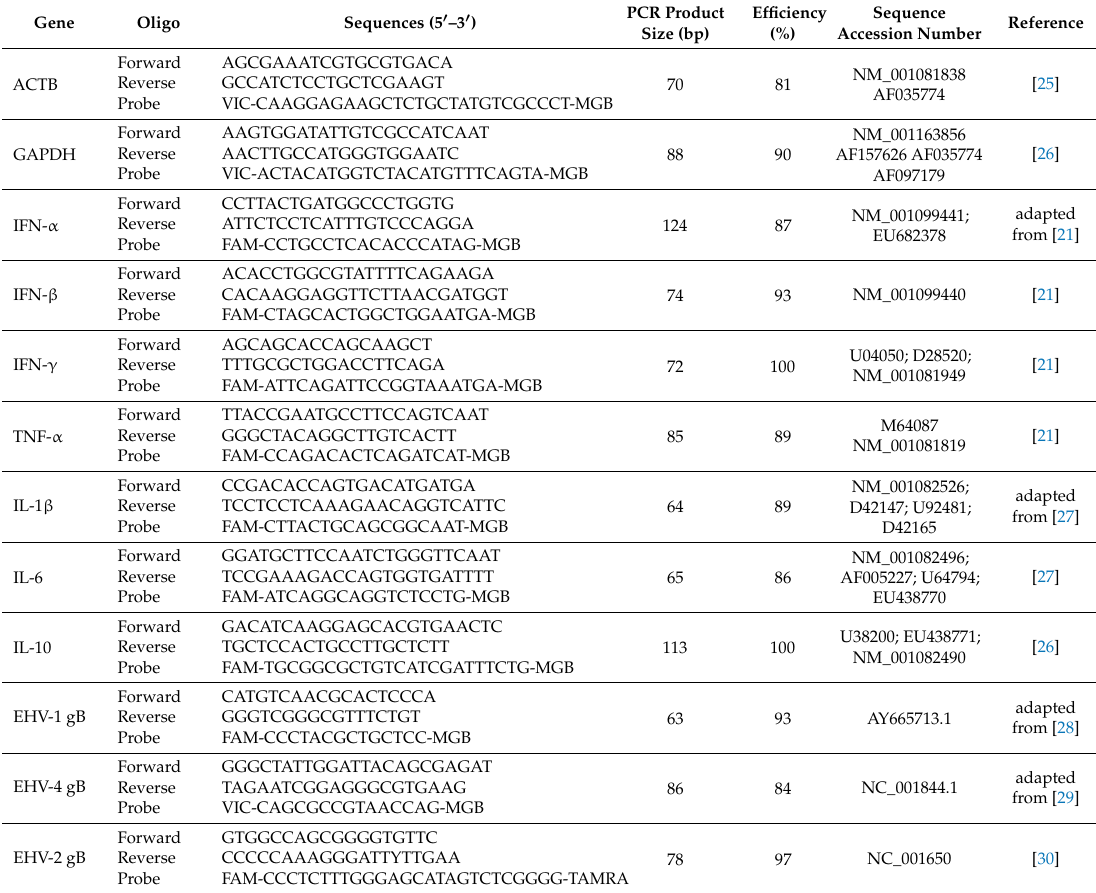
Table 1. Primers, probes, and efficiency information: qRT-PCR of cytokines in upper part and qPCR of EHV in lower part (ACTB, actin β ; GAPDH, glyceraldehyde 3-phosphate dehydrogenase; IL, interleukin; IFN, interferon; TNF, tumor necrosis factor; EHV, equid herpesvirus ; gB, glycoprotein